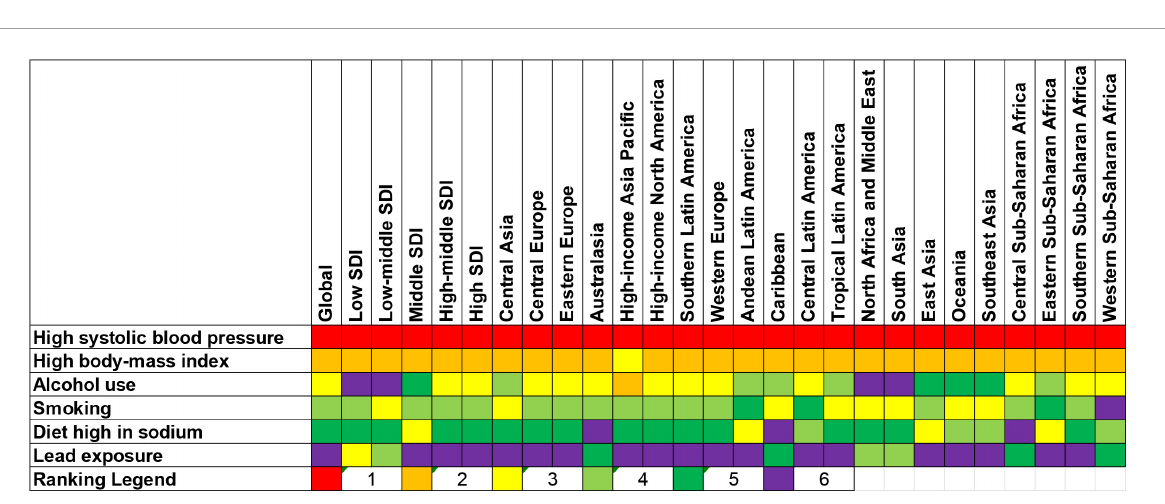
FIGURE7 Ranking for all risk factors of atrial fibrillation according to the proportion of age-standardized disability-adjusted life-years (DALYs) rate by locations in 2019. For each risk factor, a higher ranking indicates that it contributed to a higher proportion of age-standardized DALYs rate of atrial fibrillation within a GBD